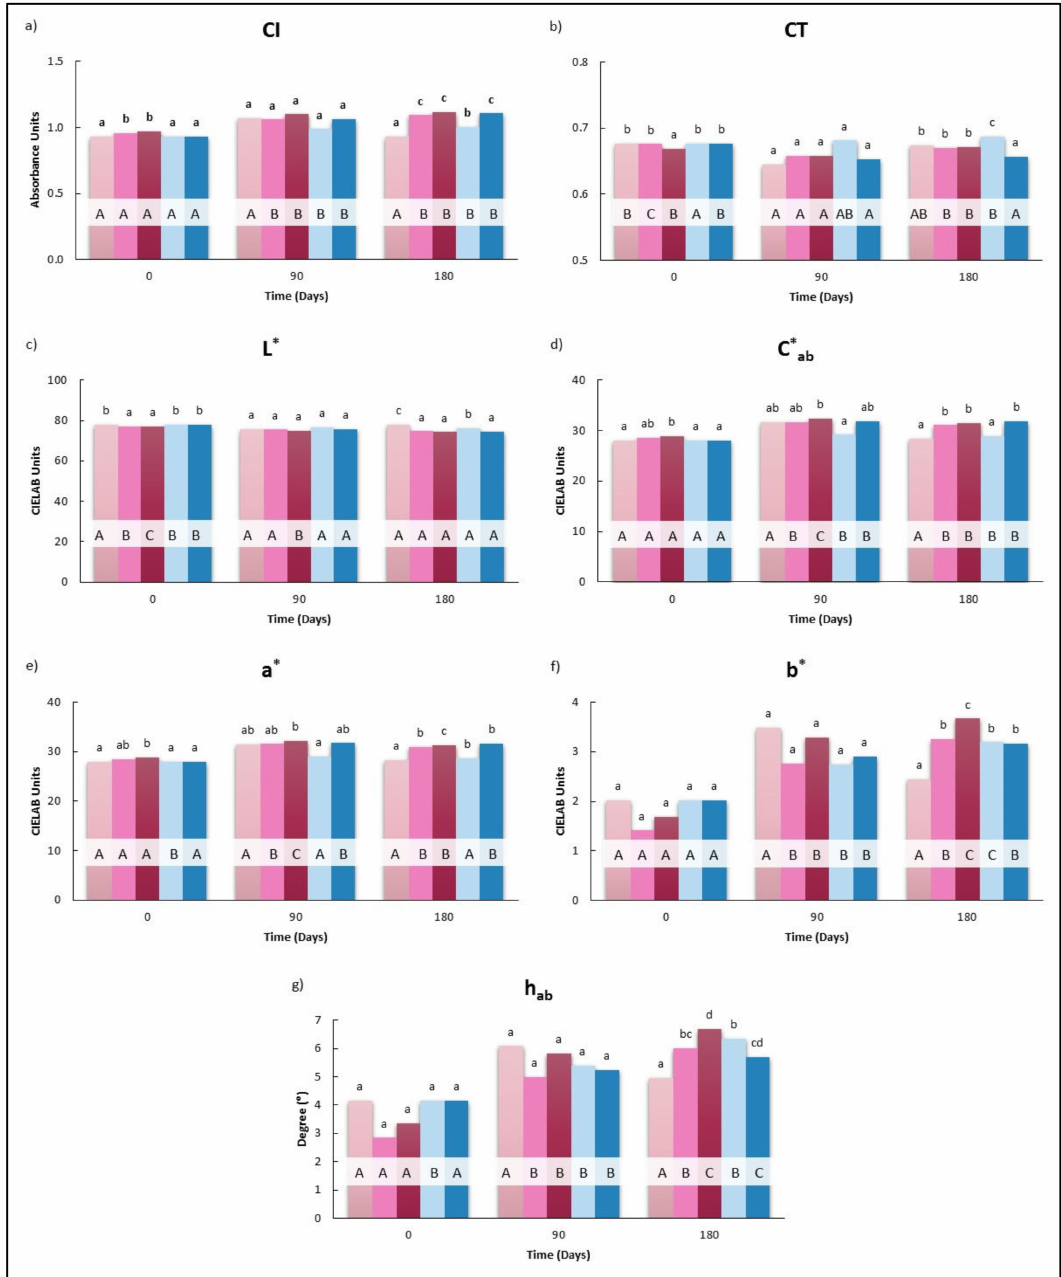
Figure 5. Effect of the application of HHP and maceration with holm oak chips on the evolution of chromatic characteristics in Tempranillo wine: ( a ) Color intensity (CI), Absorbance Units; ( b ) Tint (CT); ( c ) Lightness (L*), CIELAB Units; ( d ) Chroma (C* ab ), CIELAB Units; ( e ) Red − greenness (a*), CIELAB Units; ( f ) Yellow − blueness (b*) CIELAB units; ( g ) Hue angle (h ab ), degree ( ◦ ). B: Wines bottled without any treatment; HHP5, HHP30: Wines bottled after maceration of holm oak chips (5 g/L) with HHP treatments (400 MPa, 5 and 30 min). M and T: Wines bottled after storage for 45 days in tanks whit and without maceration of holm oak chips (5 g/L). Different lower case letters indicate a significant difference ( p < 0.05) among the treatments for the same day. Different capital letters indicate a significant difference ( p < 0.05), for the same treatment on different